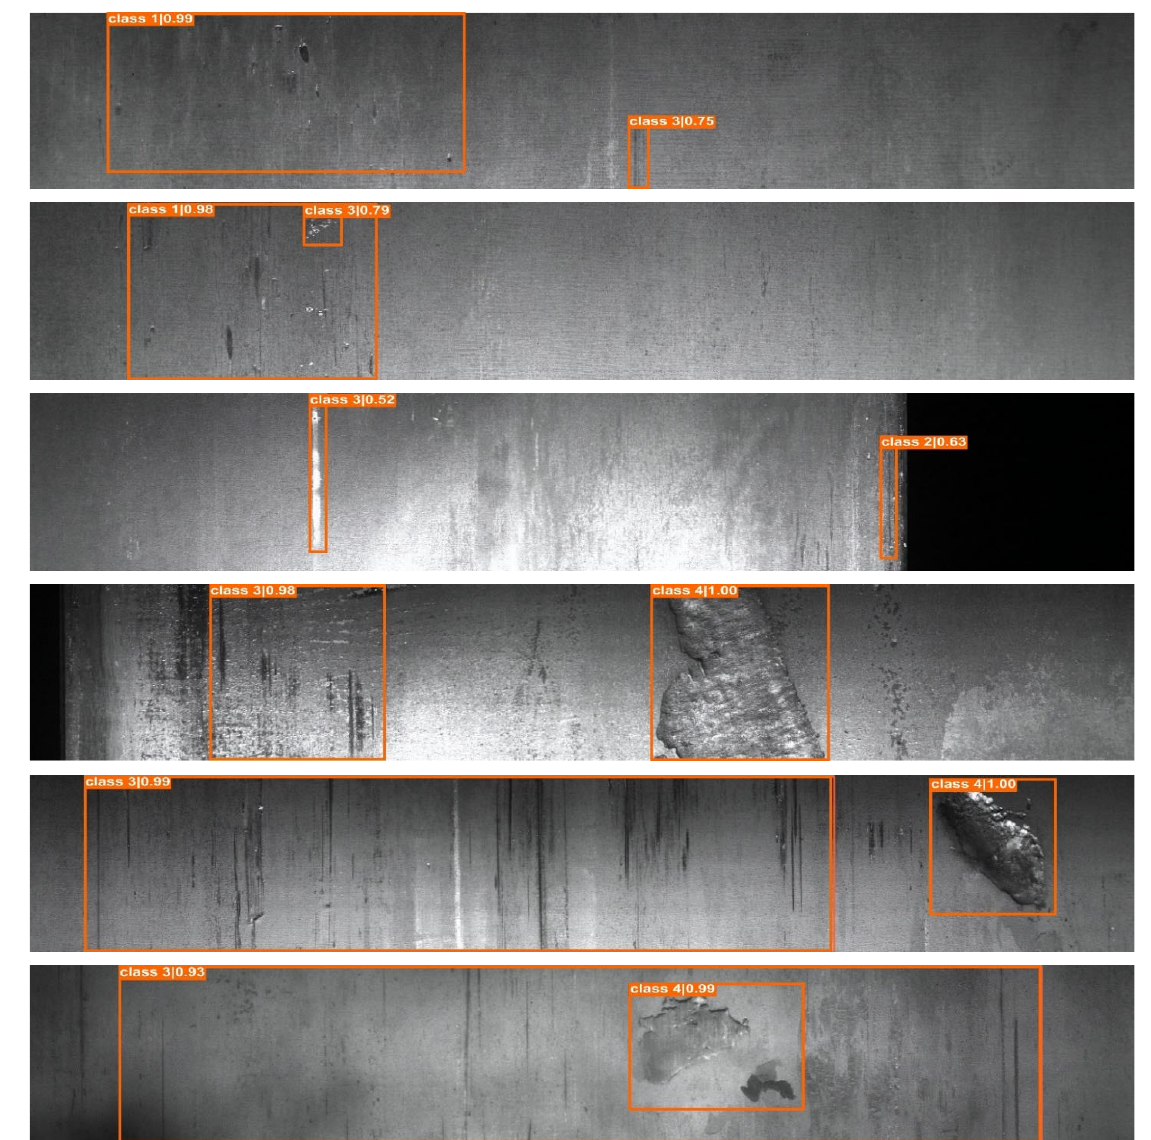
Figure 10. Sample of multi ‐ class defects localization results of the Severstal steel dataset.